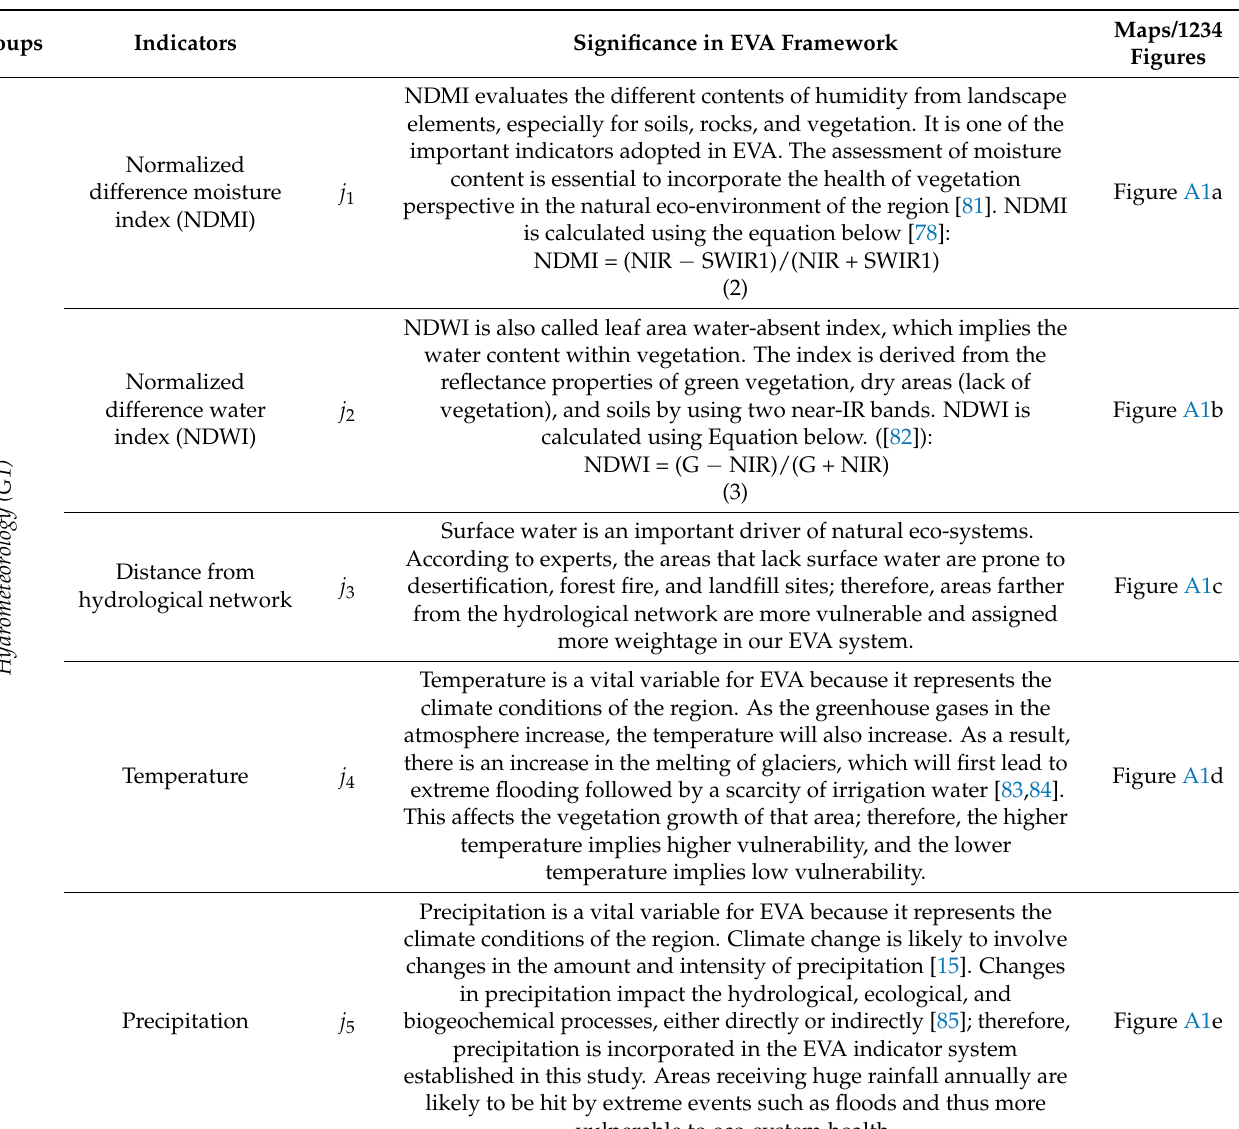
Table 2. The allocation of indicators in each group and their significance in the EVA framework.